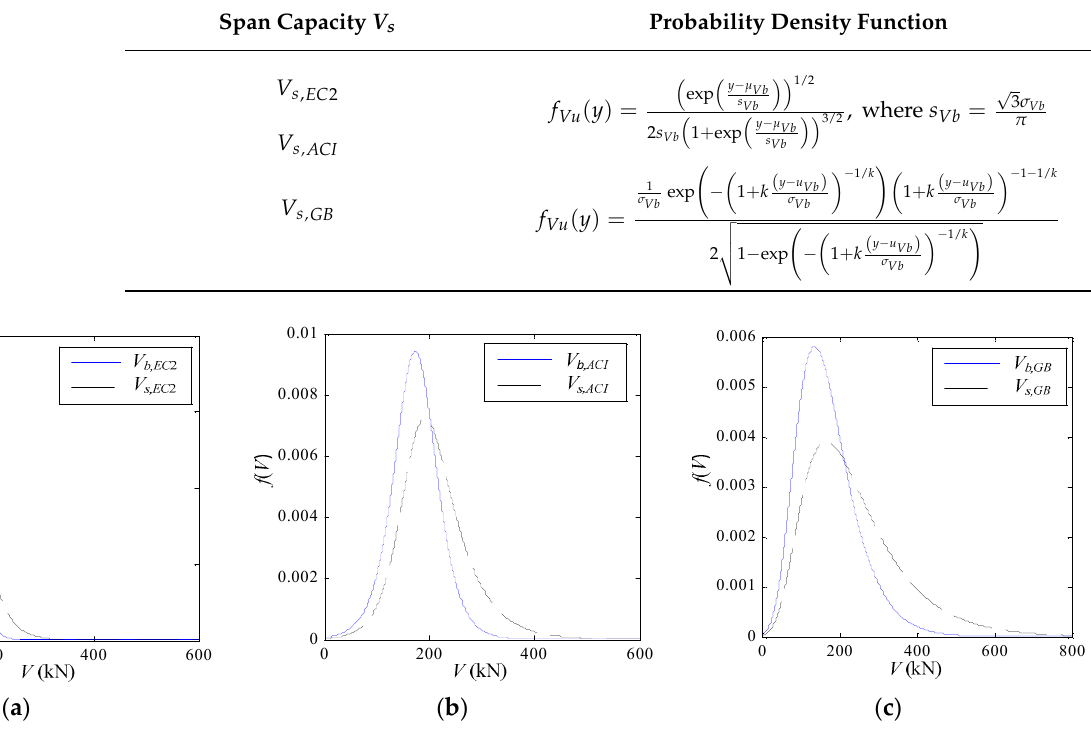
Figure 6. Comparison of the PDFs of V b and V s . ( a ) EC2. ( b ) ACI. ( c ) GB.